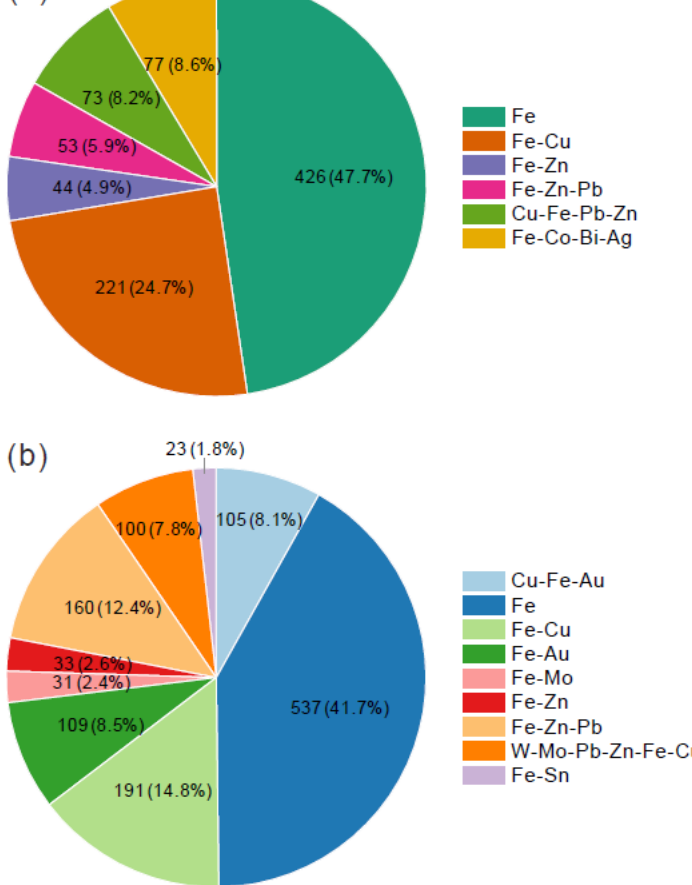
Figure 2. Number and proportion of EPMA ( a ) and LA-ICP-MS ( b ) data of magnetite from different mineralization types of skarn deposits. Nearly half of the data are from Fe skarn deposits.